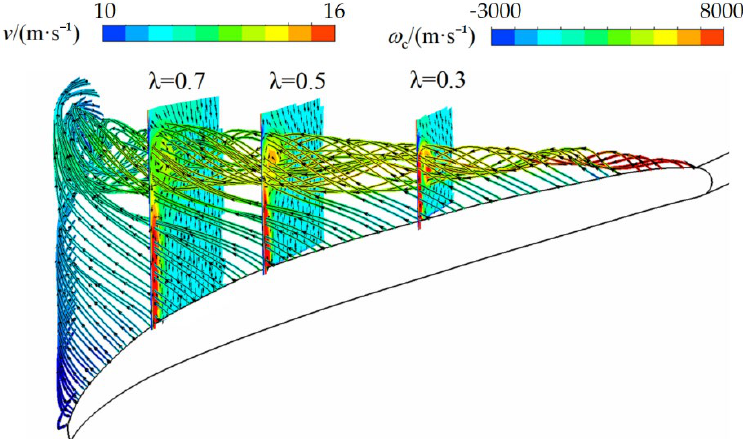
Figure 6. 3D streamlines of the tip leakage flow. The colors in the three measurement planes show the norm of the circumferential vorticity.